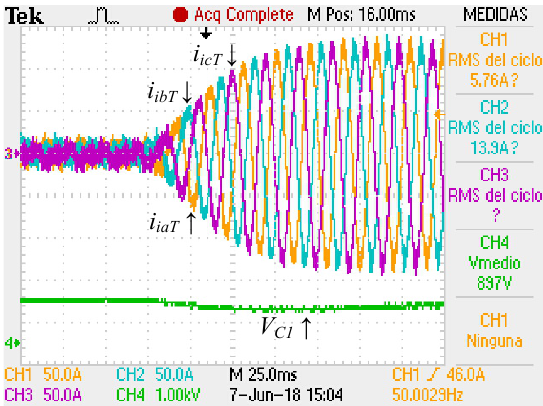
Figure 11. VSC i input currents and V C 1